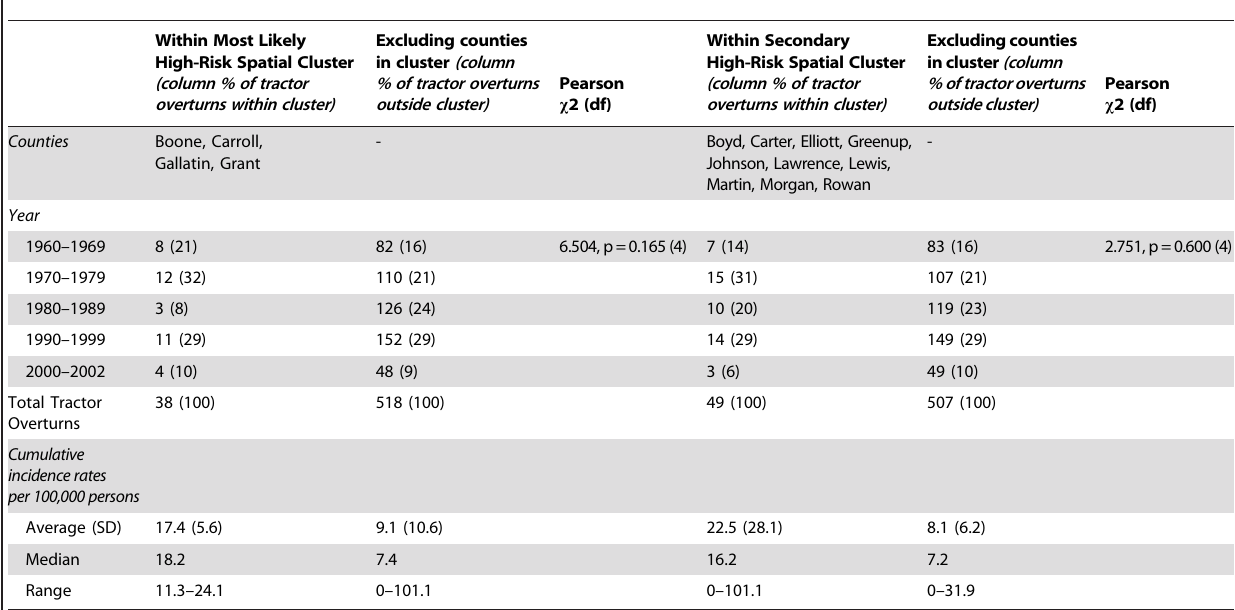
Table 2. Descriptive characteristics of tractor overturns inside and outside purely spatial high-risk clusters.